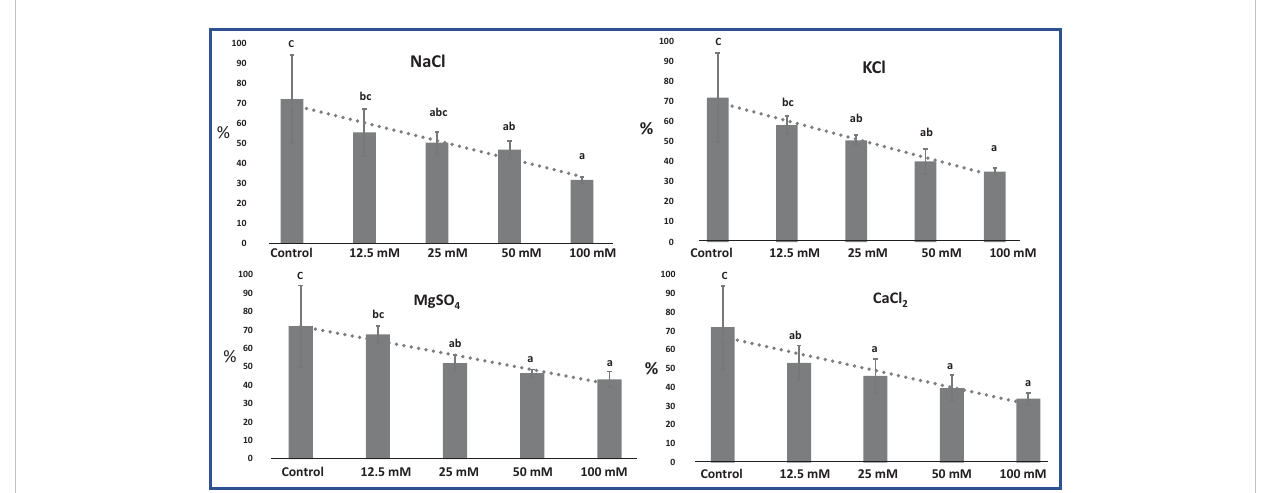
FIGURE 3 Effect of 12.5, 25, 50, and 100 mM concentrations of NaCl, KCl, MgSO 4 , and CaCl 2 salts on leaf relative water content (%) in an M. longifolia leaf sample. The data are represented as mean ± standard deviation (n = 3). The different letters on the bar graph show the signi fi cantly different groups according to the Duncan test ( a =